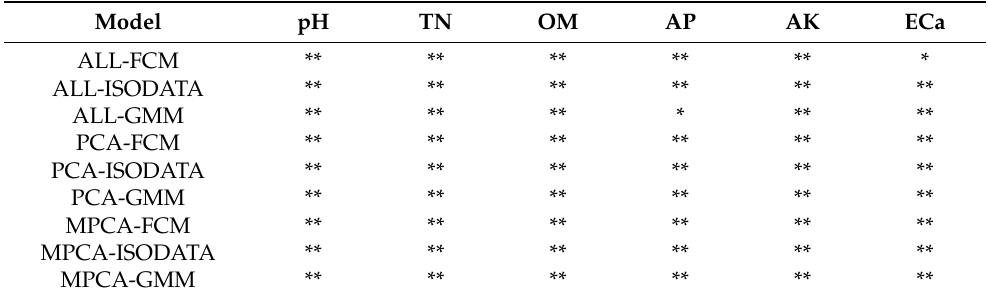
Table 5. Tukey’s test for the soil variables when the village was divided into two classes, considering classes defined with the nine clustering models.